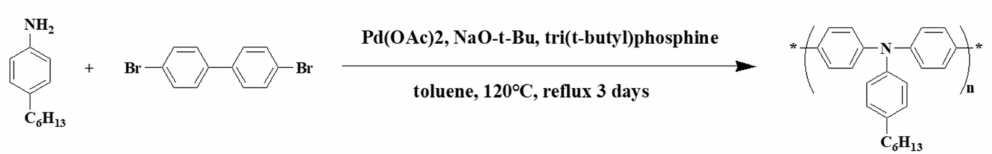
Figure 1. Synthetic route of PTPA-C6.